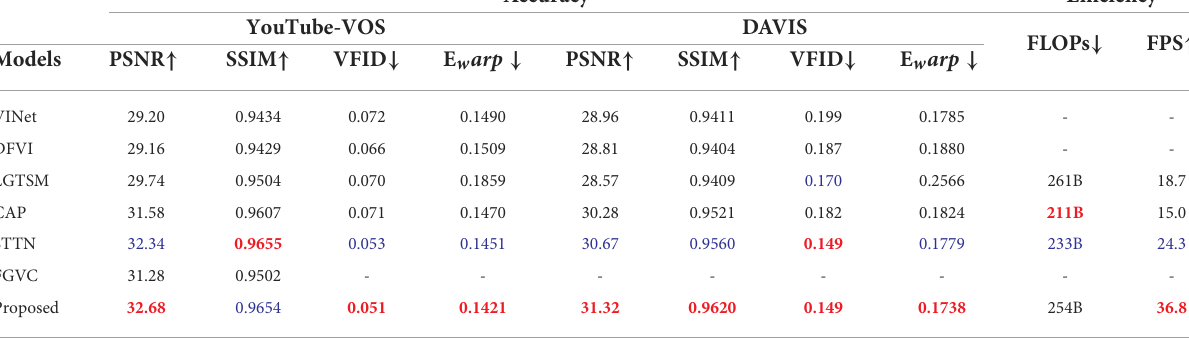
TABLE 1 Quantitative results of video completion on YouTube-VOS and DAVIS